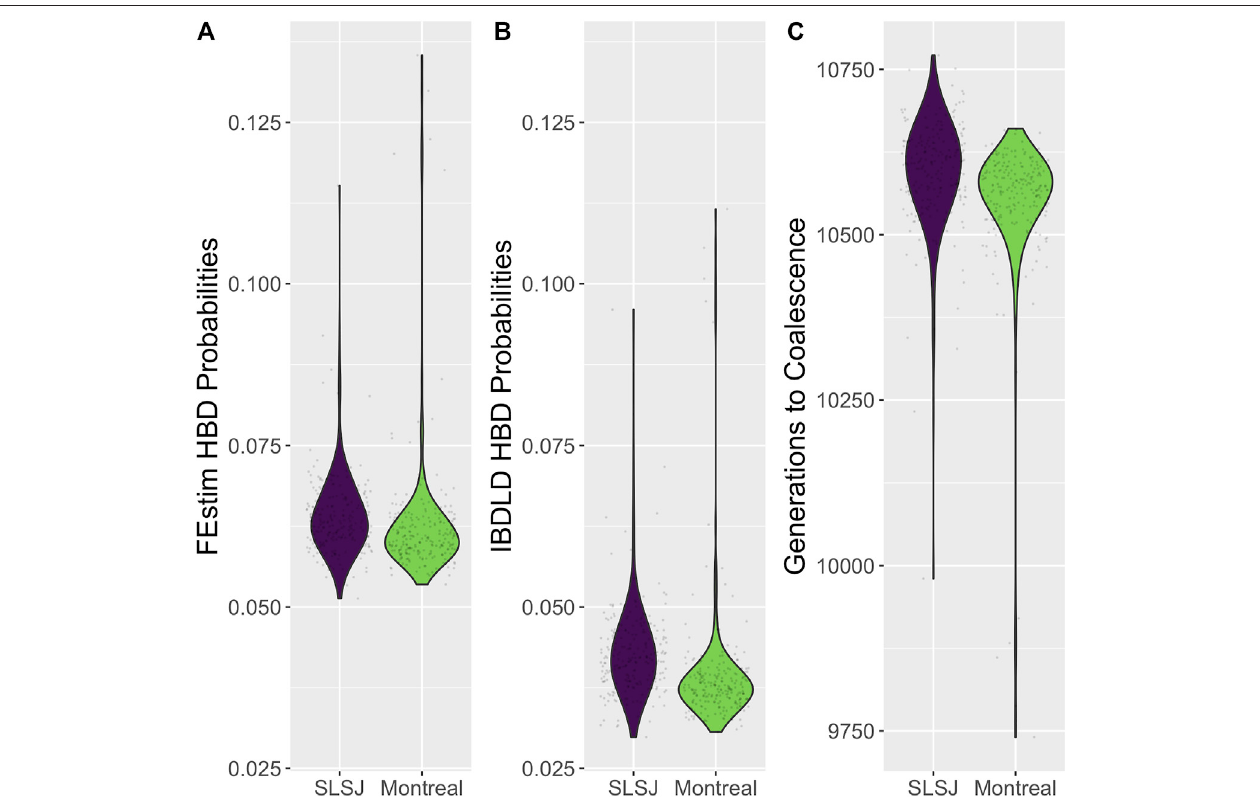
FIGURE 3 | Distributions of inferred homozygosity by descent (HBD). Violin plots of the distributions across probands, averaged across SNPs and simulation replicates, of (A) HBD probabilities estimated from FEstim; (B) HBD probabilities estimated from IBDLD; (C) time to coalescence, in generations, obtained from the observed study and coalescent/gene genealogies.